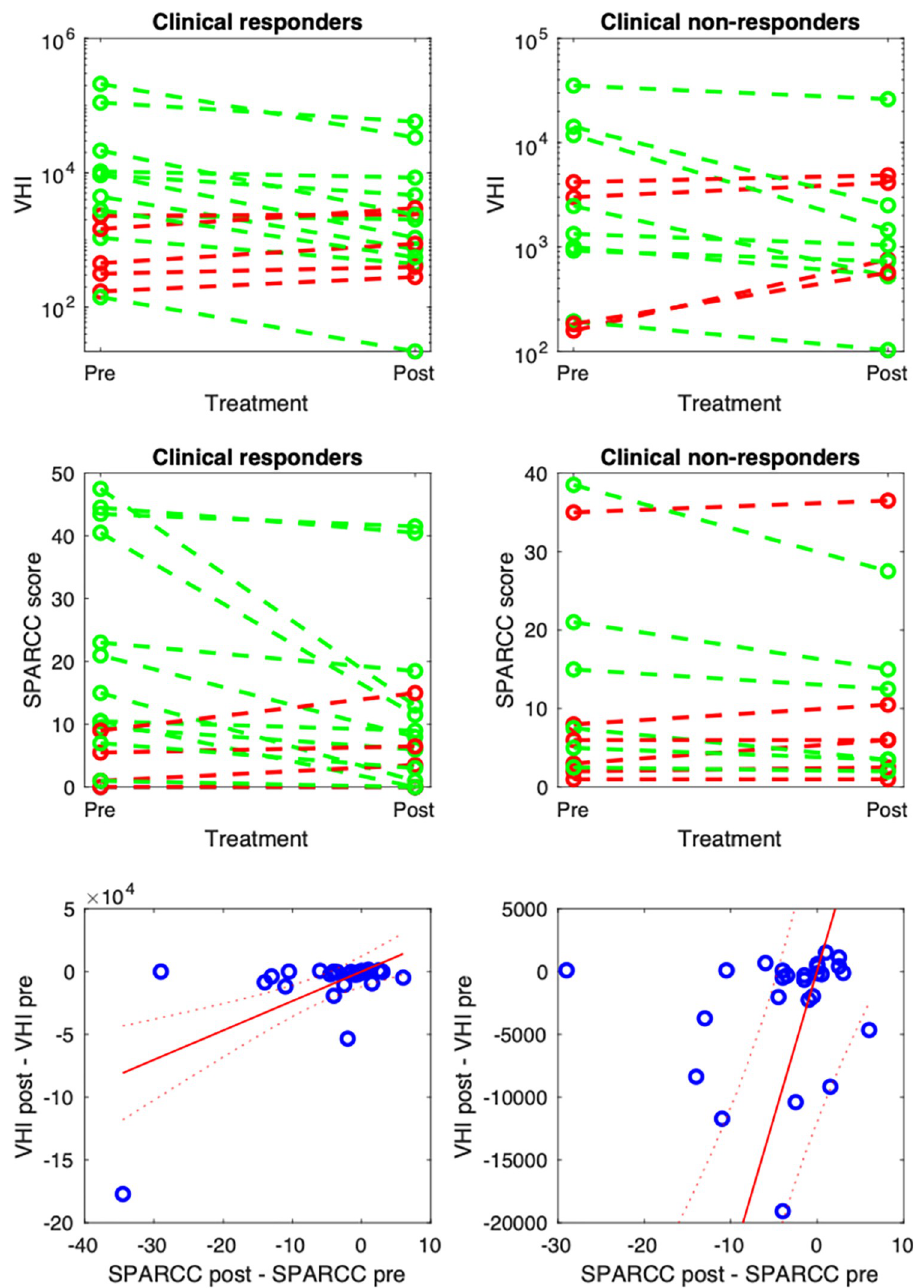
Fig 9. Spaghetti plot for V HI and SPARCC scores on pre- and post-treatment scans. Subjects with improving inflammation (based on imaging assessments by either V HI or SPARCC score) are shown in green; subjects with worsening inflammation are shown in red. The first row shows results for VHI and the second shows results for SPARCC. The third row shows a scatterplot of VHI changes against SPARCC changes for individual subjects, using the full data range (bottom left) and truncated y-axes (bottom right). The linear regression line has identical parameters for the two plots on the bottom row.